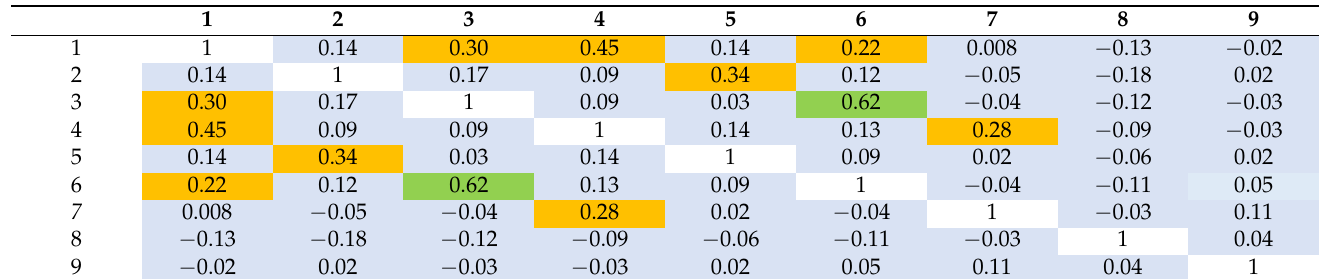
Table 2. Adjusted Rand index matrix.